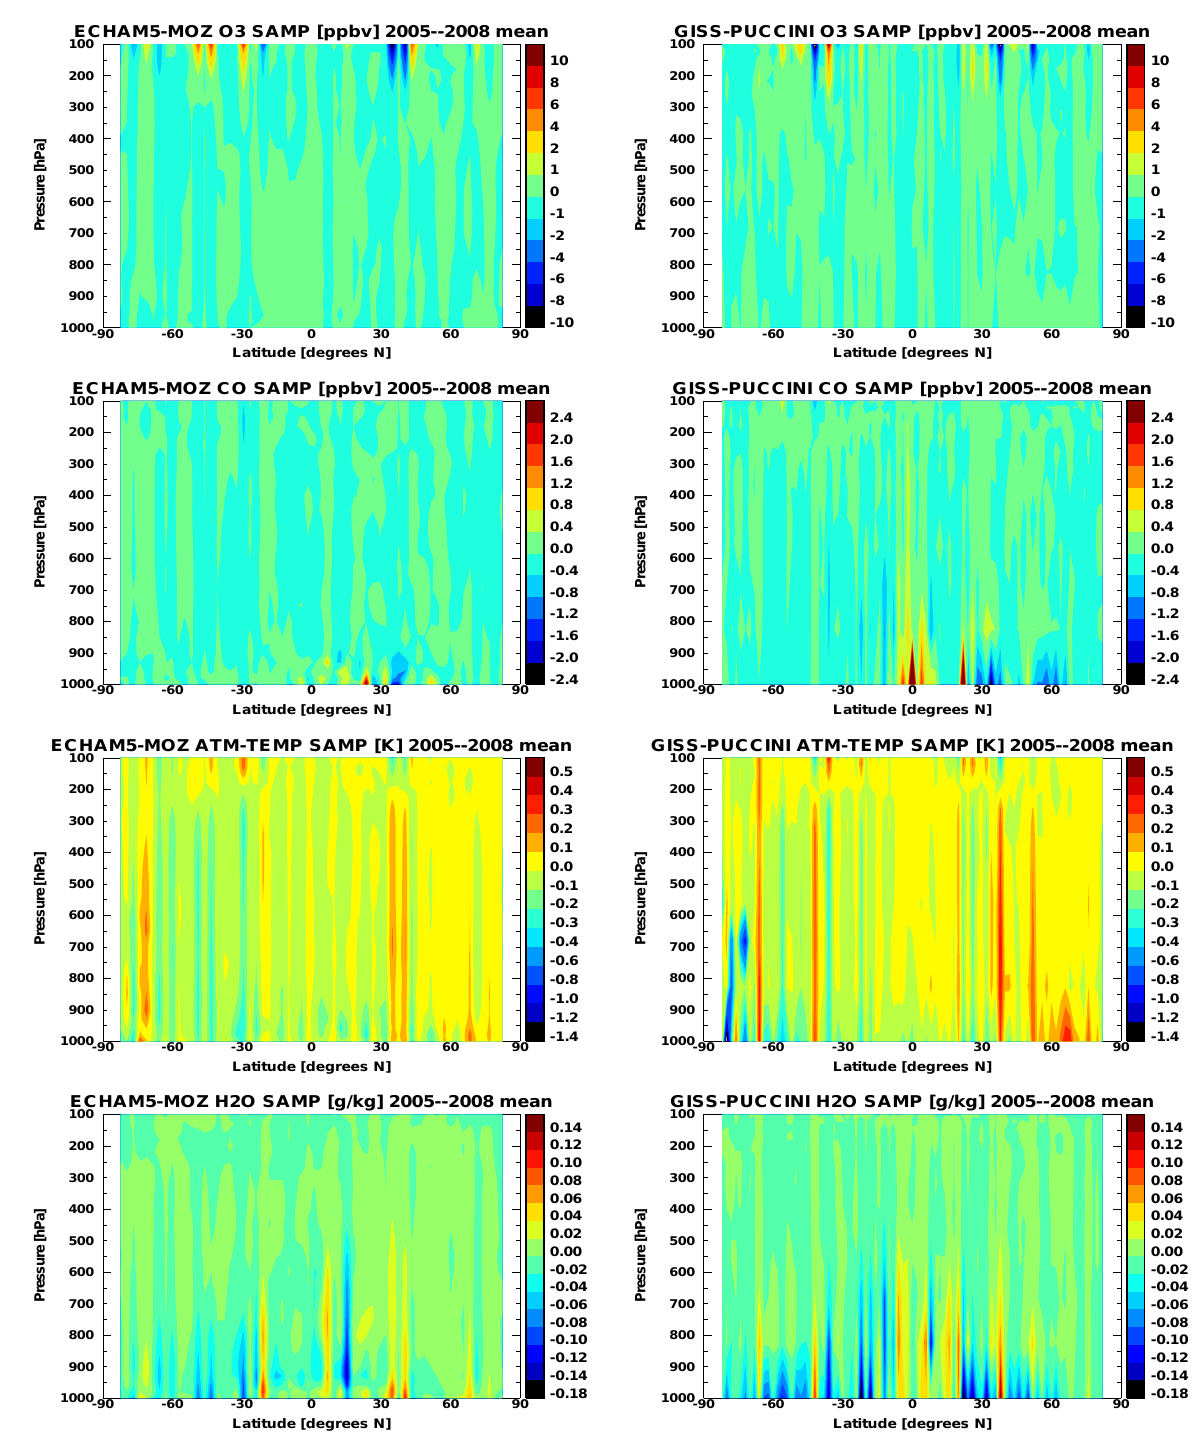
Fig. 4b. The 2005–2008 monthly-mean zonal-mean absolute errors due to sampling. The layout of the figures are similar to those in Fig. 4a for both